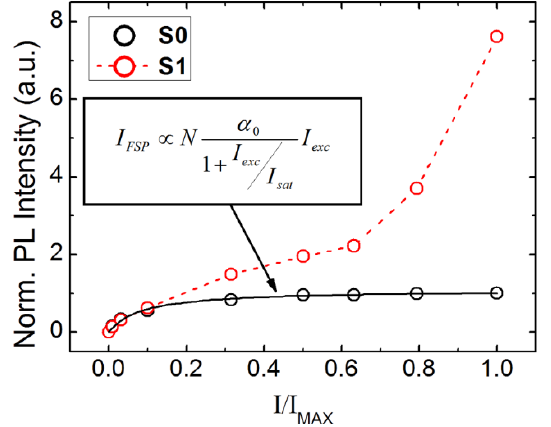
Figure 4. Comparison between the photoluminescence of the fluorescent polymer film coated on quartz, S0 sample (black circles) and on the ZnO layer, S1 sample (green circles) as a function of the normalized pumping intensity ( I / I MAX ). The plotted PL intensity values are taken at λ ~ 468 nm and normalized by the maximum PL intensity recorded for the S0